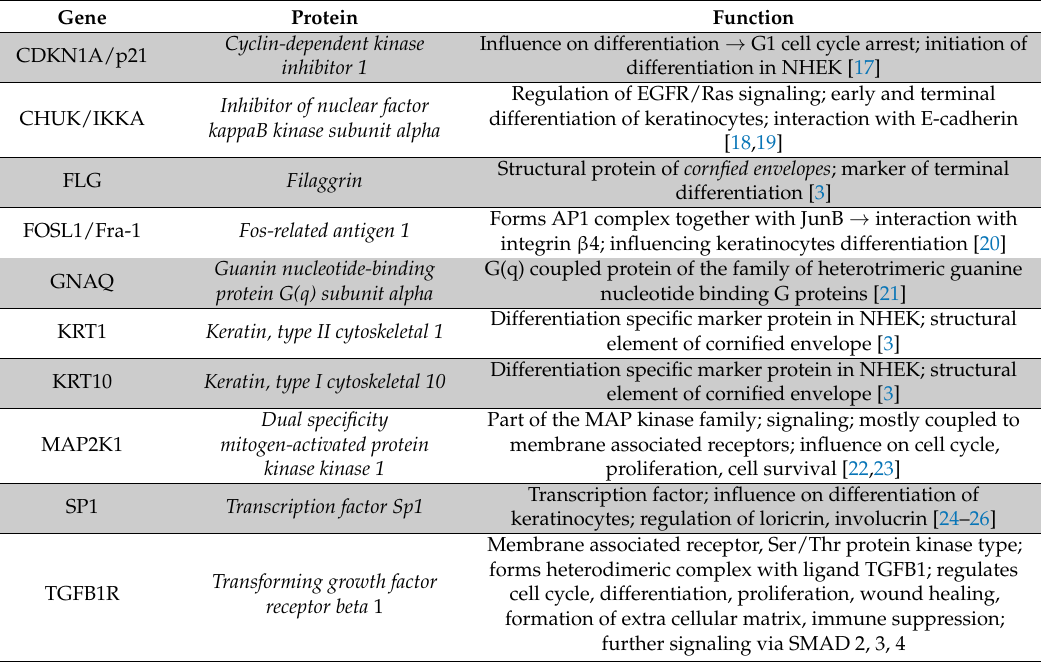
Figure 5. Quantitative Real-Time Array (Development-Keratinocyte differentiation H96 array—BioRad) after 60 h incubation of NHEK with γ -PSL (100 µ g/mL) on the relative, normalized gene expression of differentiation specific genes in relation to the untreated control (normalized expression = 1); #: genes selected for subsequent qPCR cross validation. Data are related to the independent array experiments ( A , B ). Table 1. Known functionality of selected genes from qPCR screening array, which is related to the differentiation of keratinocytes.